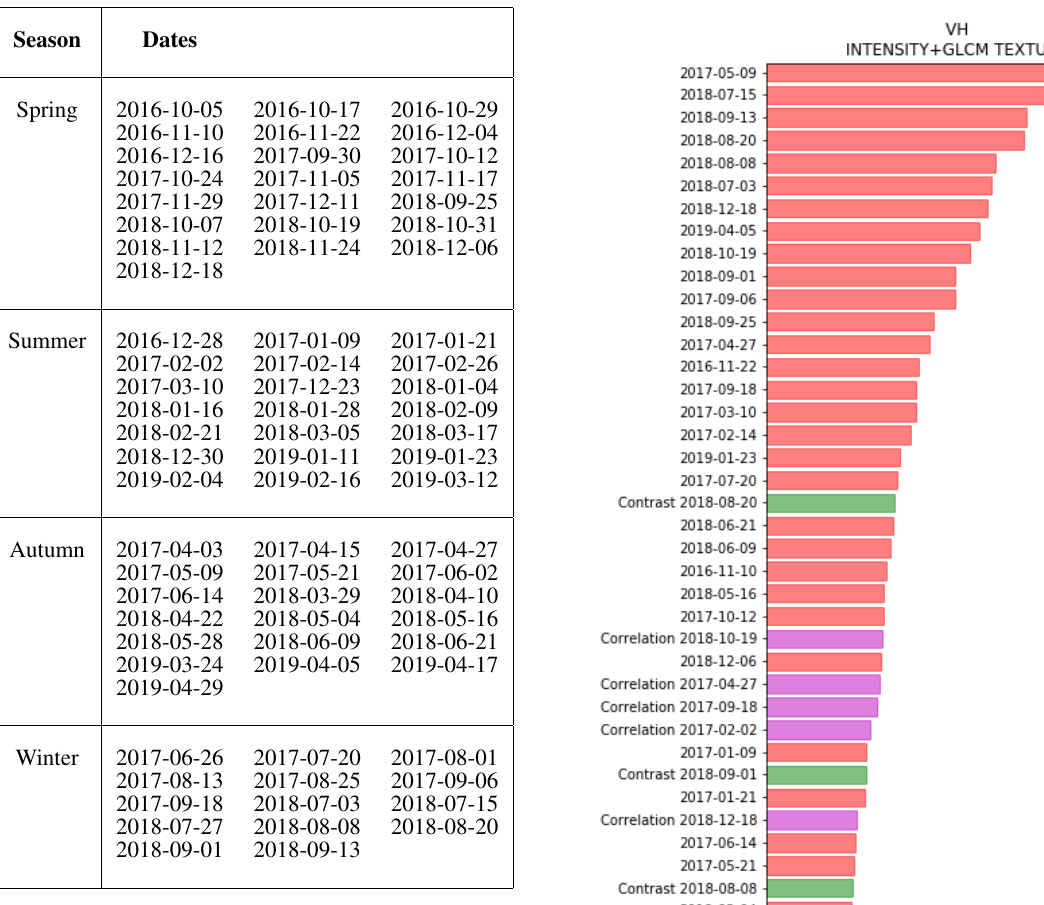
Table 1. Description of the images’ dates corresponding to each season. Figure 3. Variable relative importance of Random Forest classification for the dataset formed by the Complete Intensity+GLCM values in the VH polarization. The dataset if formed by 380 variables, the top 38 are presented in the figure. Different variables are represented as follows: Intensity elements (red), GLCM Contrast texture (green), and GLCM Correlation texture